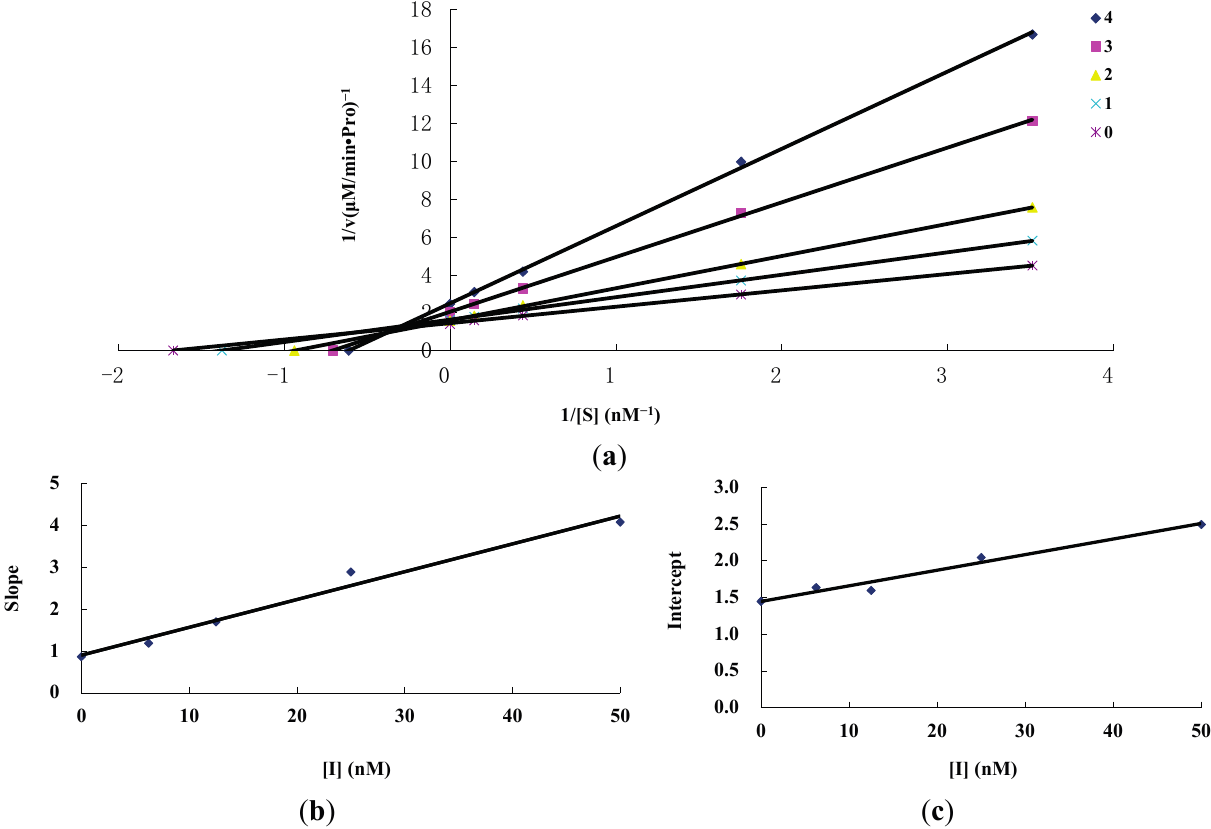
Figure 4. Inhibition kinetics of rotenone on mitochondrial complex I by Lineweaver–Burk plots. Concentrations of ( a ) for curves 0–4 were 0, 6.25, 12.5, 25 and 50 nM, respectively; Figure ( b ) and ( c ) represent the secondary plot of the slope and the intercept of the straight lines versus concentration of inhibitor,